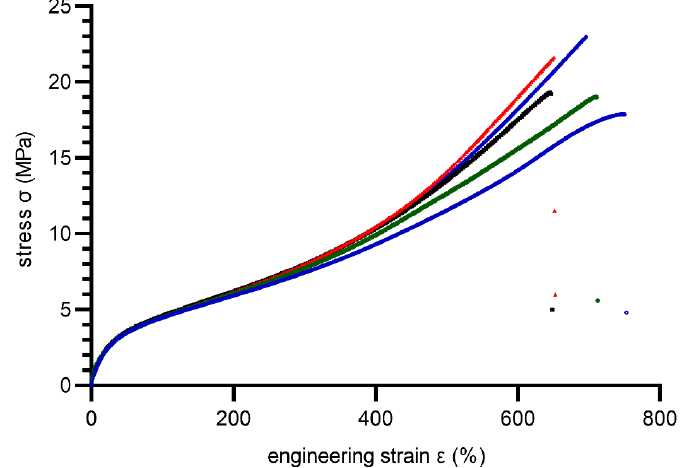
Figure 7. Stress–strain curves obtained during the tensile test for 80 ShA PUR material (solid lines represents different specimens, dots–measurement points after break).